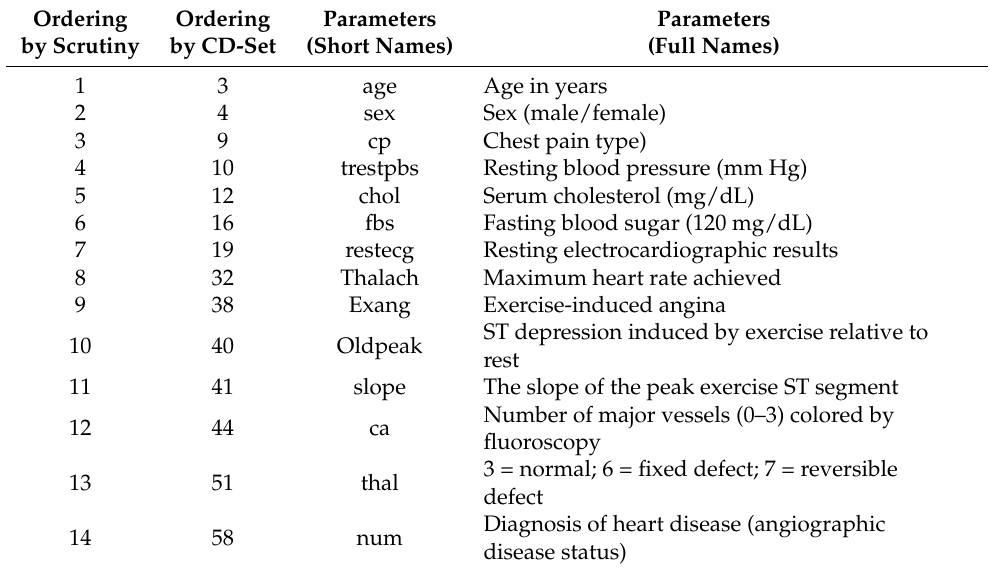
Table 1. Brief description of parameters in CD-set.